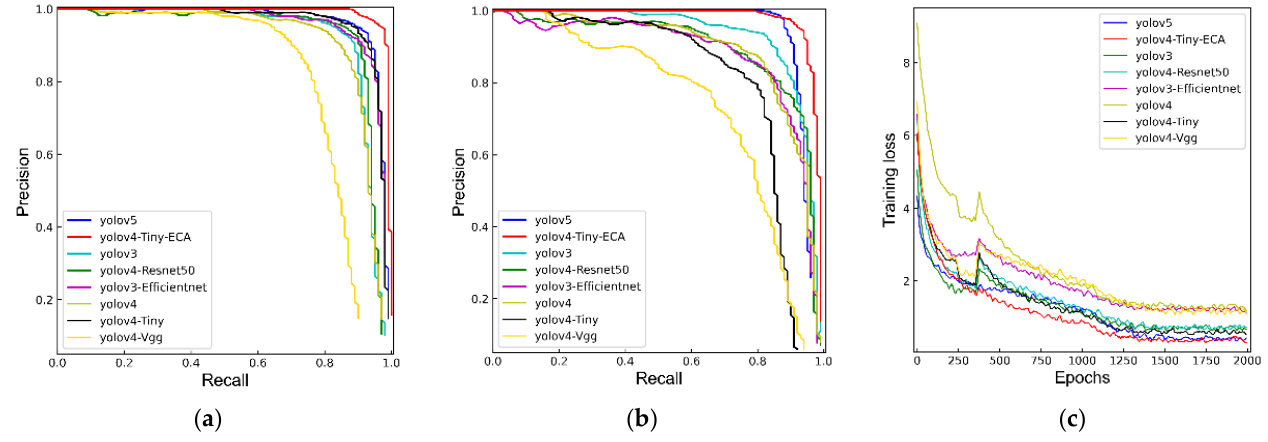
Figure 14. The precision – recall curves and loss curves: ( a ) precision – recall curves of angle feeding; ( b ) precision – recall curves of vertical feeding; ( c ) loss curves of different network models.